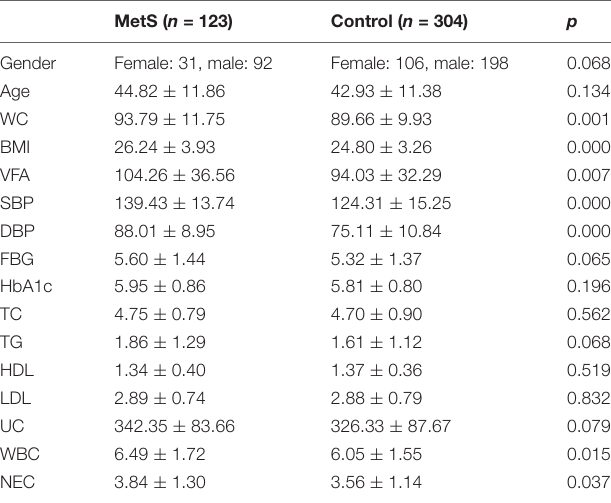
TABLE 1 | The major demographic and serum characteristics of the MetS subjects and the control group.